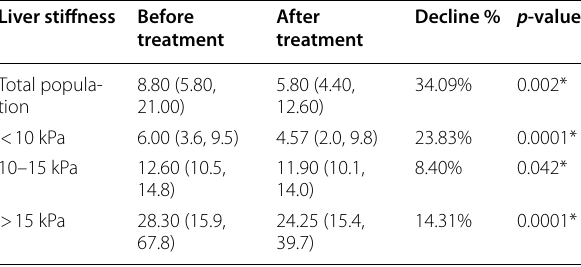
Table 2 Comparison of the liver stiffness (LSM) between before and after treatment within each liver stiffness